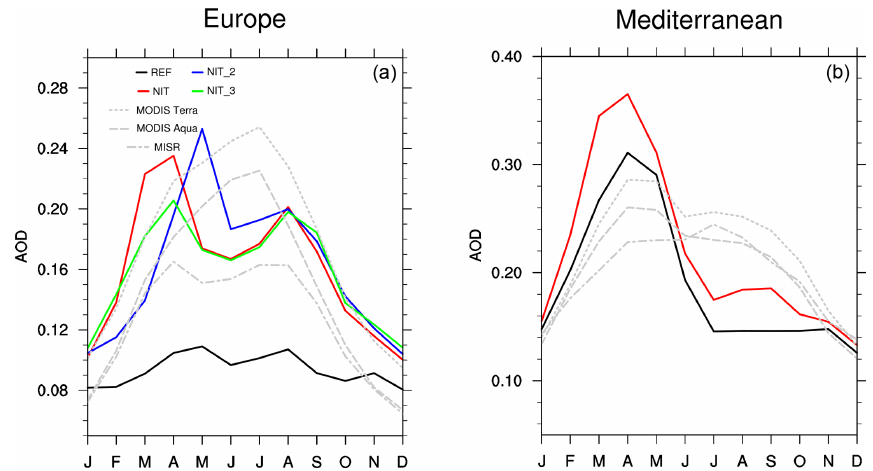
Figure 8. Average total aerosol AOD 550 annual cycle simulated by ALADIN-Climate, over the period 2001–2016 (2003–2016 for MODIS Aqua), with (NIT) and without (REF) A&N and measured by two satellite instruments (MODIS and MISR) over Europe (a) and the Mediter- ranean Sea (b)